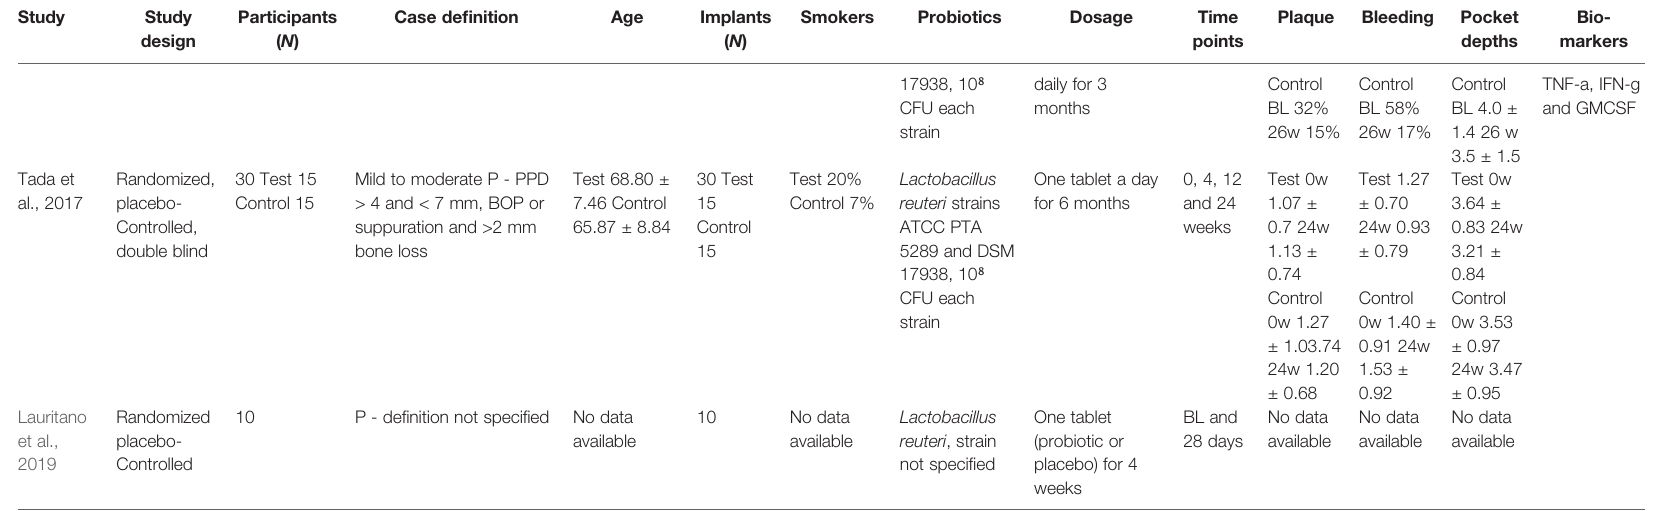
The bold font and asterisk indicate signi fi cance between baseline and latest timepoint and test and control, respectively. Data on bleeding presented in % refer to bleeding on probing and otherwise modi fi ed Gingival Index. Group A, healthy; Group B, peri-implant mucositis; M, mucositis; P, peri-implantitis; IL-1 b , interleukin- 1 b ; IL-6, interleukin-6; IL-8, interleukin-8; IL-1RA, interleukin-1 receptor antagonist; IL-4, interleukin-4; IL-7A, interleukin-7A; CCL-5, chemokine ligand-5; IFN-g, interferon gamma; GMCSF, granulocyte colony-stimulating